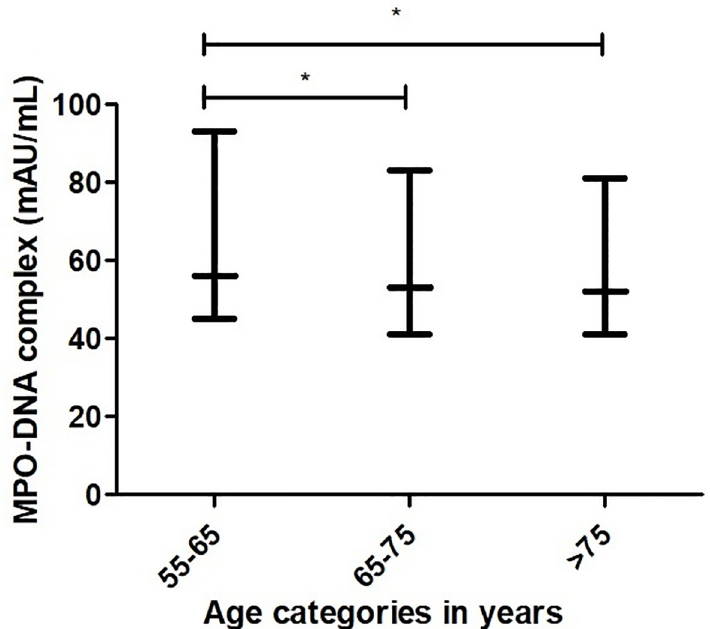
Fig 1. Distribution of MPO-DNA complex levels among age categories. � p < 0.01. Data are presented as median and 25 th -75 th percentiles. Category 55–65 years, (n = 2286) MPO-DNA complex 56 mAU/mL (45–93), category 65–75 years (n = 2467) MPO-DNA complex 53 mAU/mL (41–83), category > 75 years (n = 1674) MPO-DNA complex 52 AU/mL (41–81). Differences between age categories were analyzed using the Kruskall–Wallis test with post-hoc